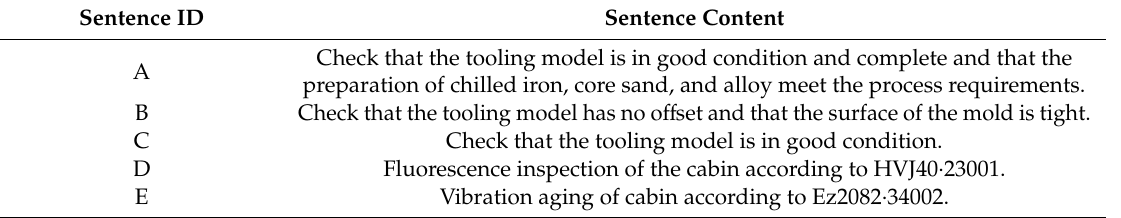
Table 3. Five sample sentences.